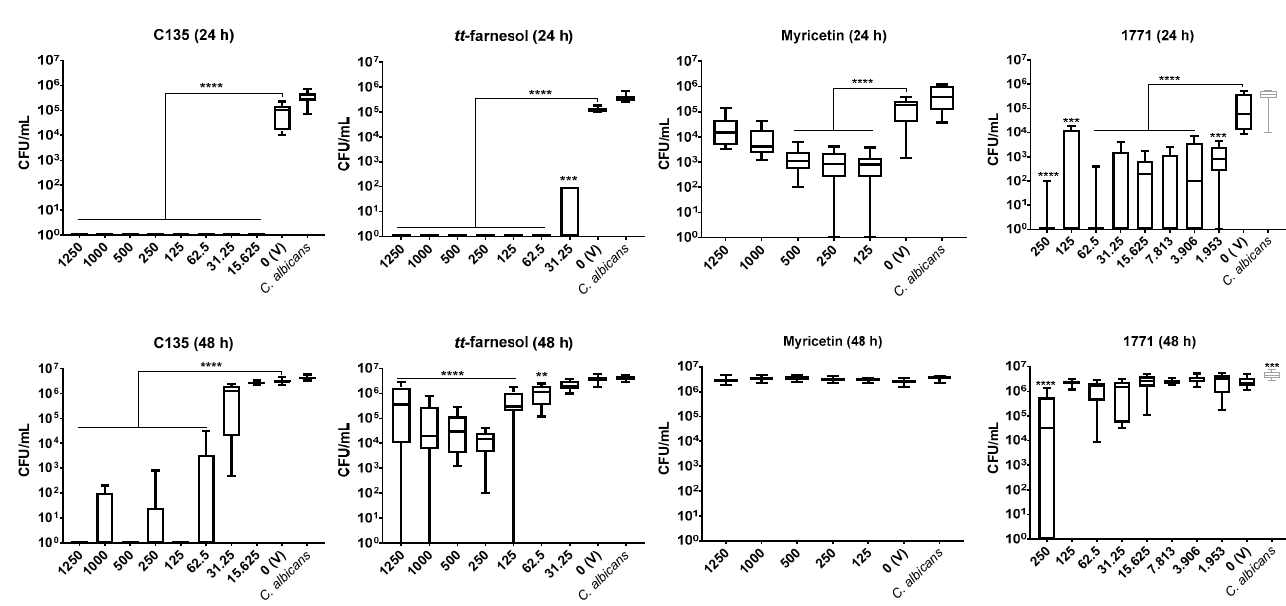
Figure 4. Antibiofilm activity of C. albicans with compounds: C135, tt -farnesol, myricetin, and 1771. On the first line are presented data of 24 h biofilm (initial biofilm formation); and right below are the data of pre-formed biofilms (48 h). The data represents median and interquartile ranges ( n = 9). Statistical differences are represented with ** ( p = 0.002), *** ( p ≤ 0.0003), and **** ( p ≤ 0.0001) (Kruskal Wallis, followed by Dunn’s test). The tabulated results are in Table S4.